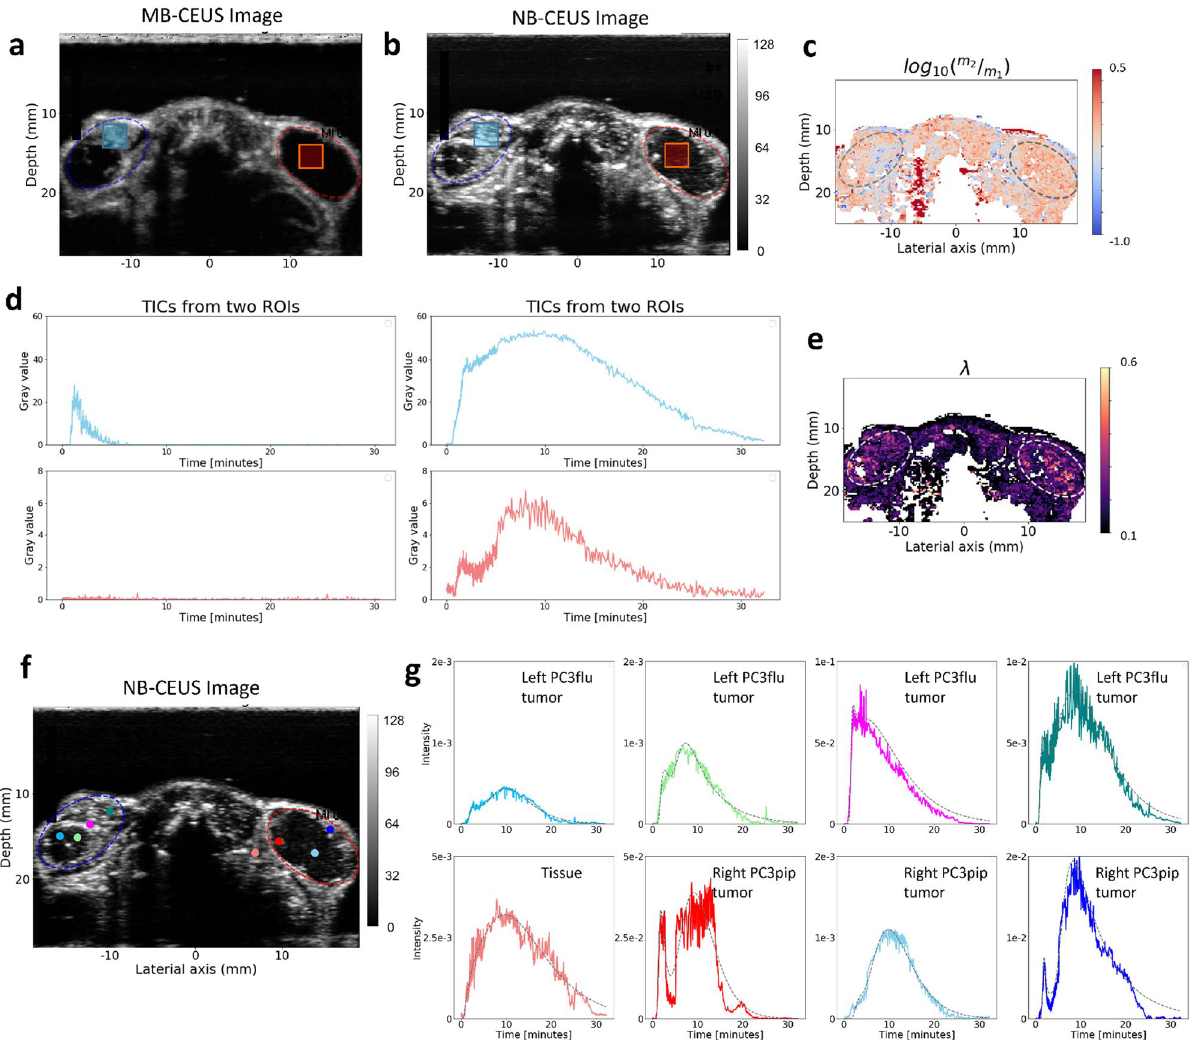
Figure 4. Comparison of parametric maps and TICs obtained on one mouse with MBs and NBs. In the top row, the maximum intensity projection of MB-CEUS ( a ) and NB-CEUS ( b ) videos are presented, with the left PC3pip and right PC3 tumor ROIs delineated in blue and red, respectively. The average TICs extracted from two rectangular ROIs within the tumors are presented in ( d ) with corresponding colors. ( c ) and ( e ) present the parametric maps of log 10 ( m 2 / m 1 ) and (cid:31) , respectively. In ( g ), a series of experimental pixel-based TICs (colored solid lines) and corresponding model fit (gray dashed lines) are extracted from the NBs-CEUS video, with the pixels’ locations indicated by corresponding colored dots in ( f ). The scales of the y-axis vary between subfigures in ( g